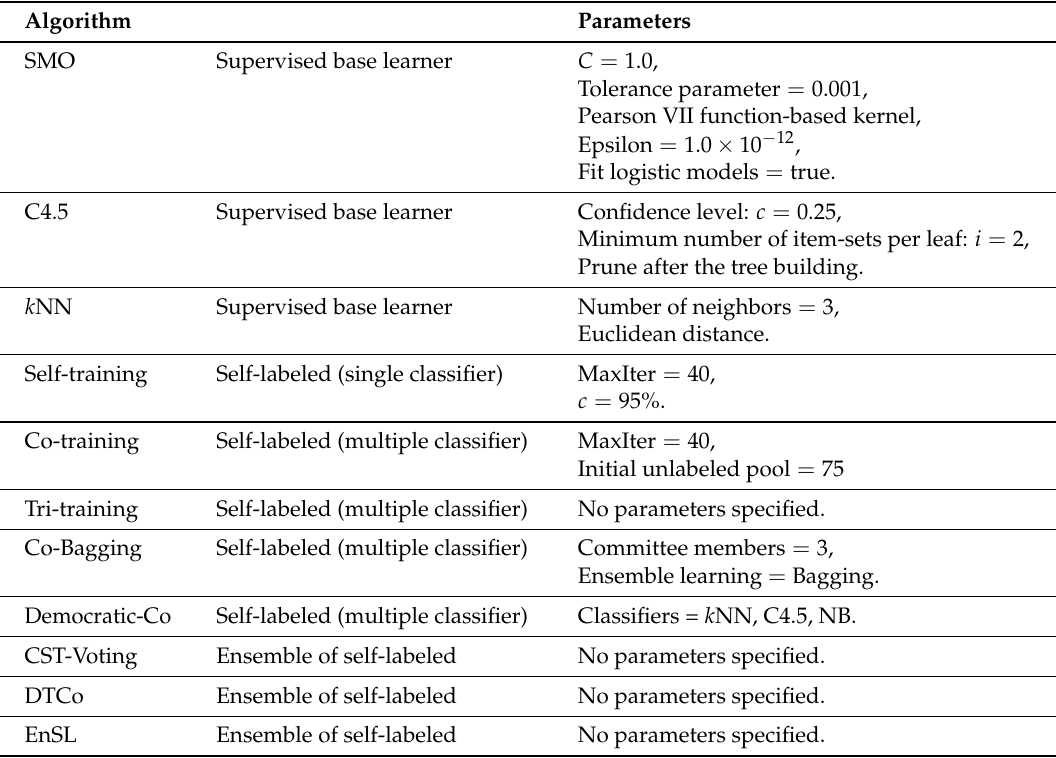
Table 1. Parameter specification for all the base learners and self-labeled methods used in the